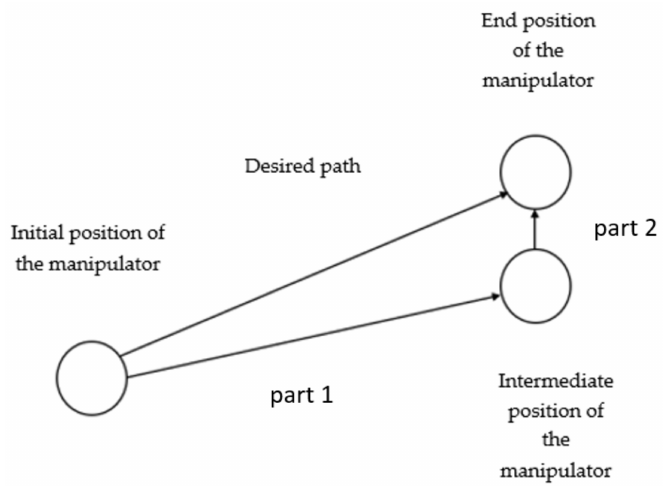
Figure 10. The manipulator movement to a given